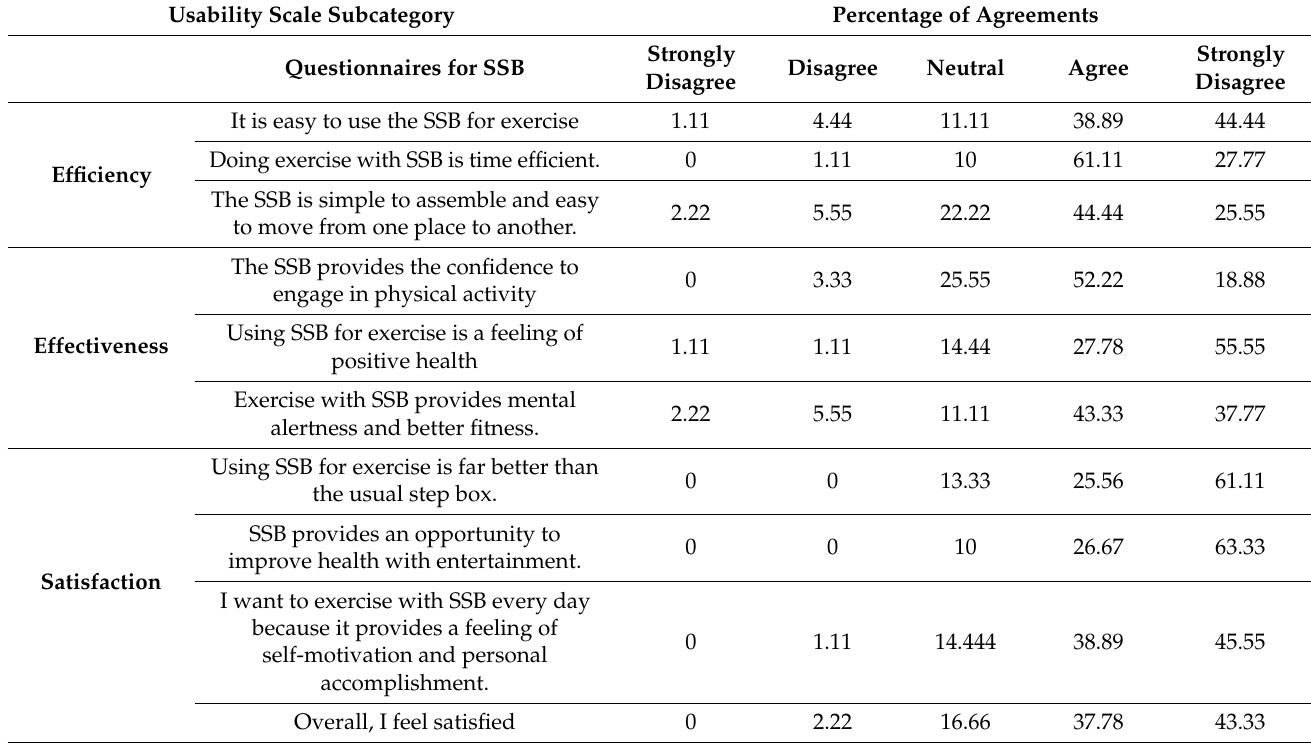
Table 2. Usability scale questionnaires average responses of SSB for N = 90.